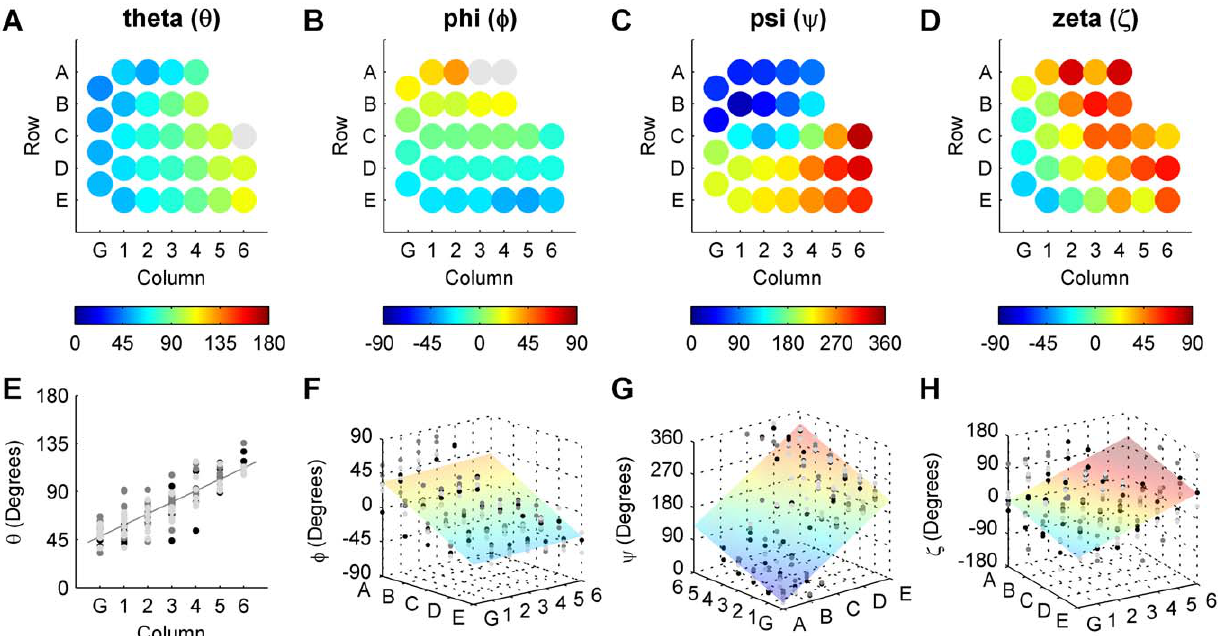
Figure 8. Dependence of h , Q , y and f on whisker identity (row and column location in the array). ( A–D ) The angles h , Q , y and f for each whisker, averaged across both right and left sides of all three rats. Color scales are different for each subplot. ( E–H ) The angles h , Q , y and f obtained from all rats, plotted against the dominant factor(s) (either row or column or both). Different marker colors (black, gray, and light gray) indicate rat of origin, and indicate that no significant differences were found across rats.